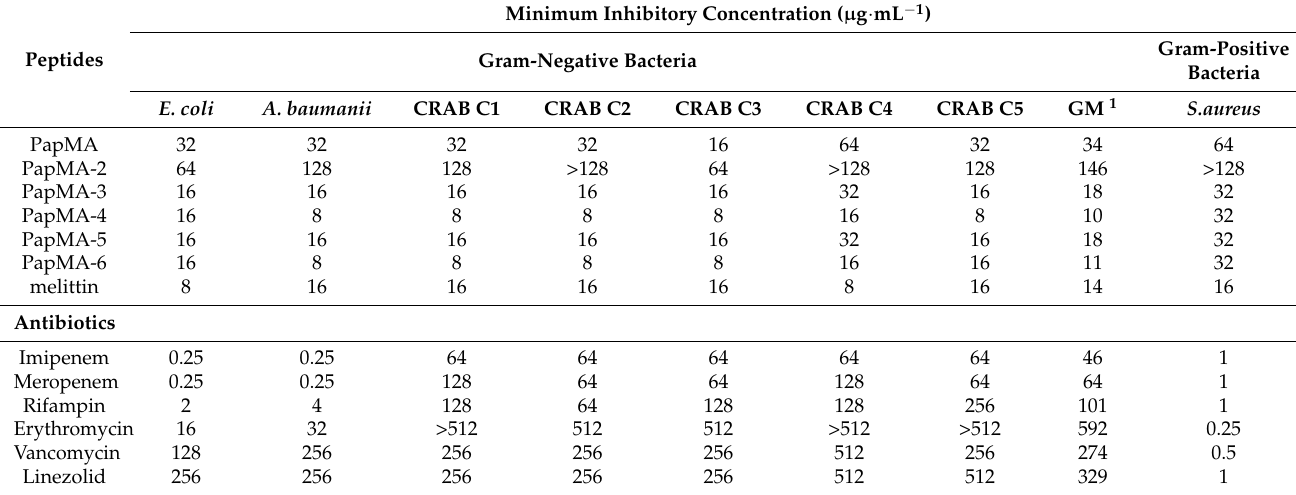
Figure 1. Helical wheel diagram of C-terminal helix from 10th to 18th residue of PapMA and its analogs after Pro hinge generated using HeliQuest at pH 7.4 [44]. Residues at the N-terminus and C-terminus of C-terminal helix are marked as N and C in the figure. Hydrophilic residues are shown in blue. Hydrophobic residues are shown in yellow. Uncharged His is shown in cyan, and Ser is shown in purple. The arrows represent the helical hydrophobic moment. Table 2. Antibacterial activities of antimicrobial peptides and antibiotics against